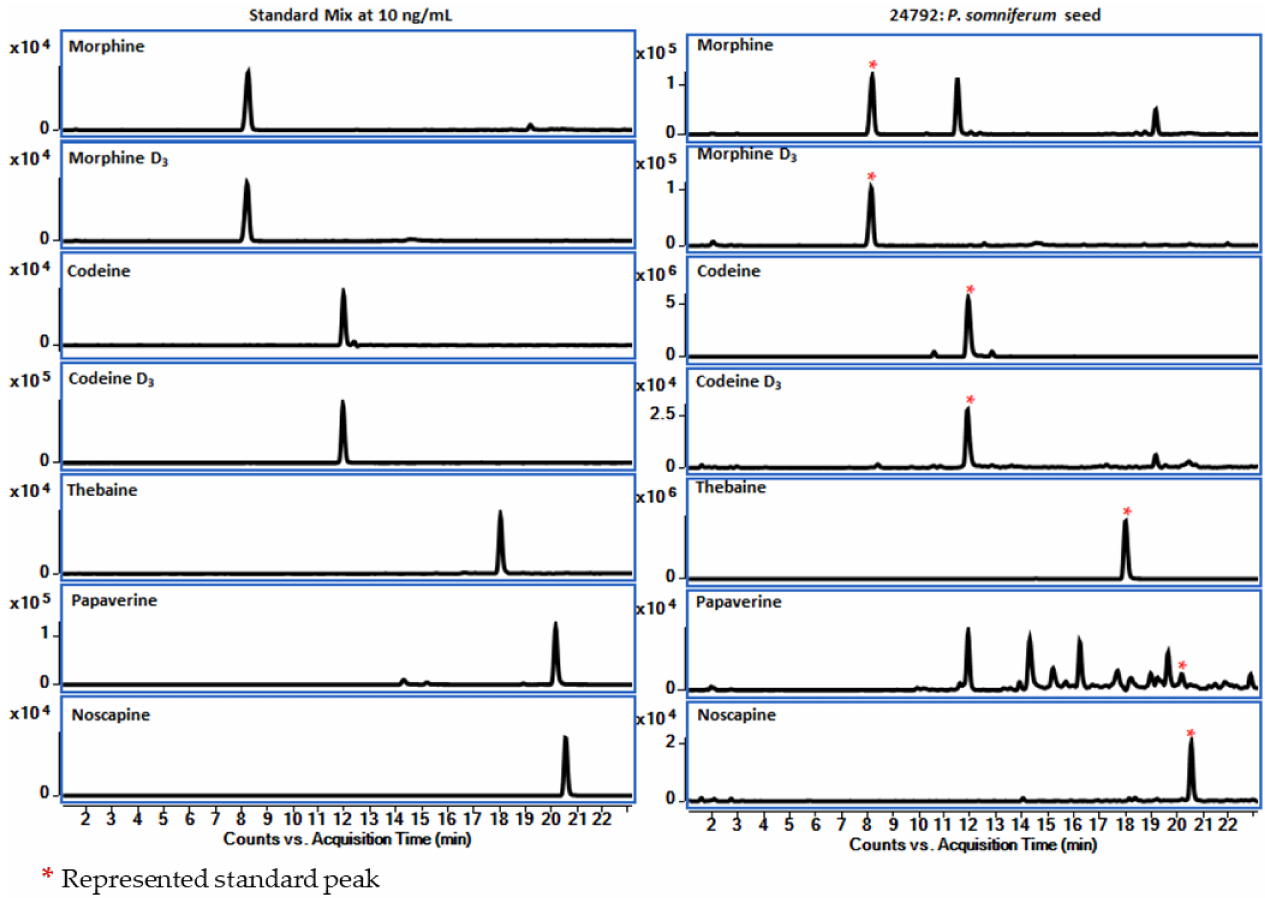
Figure 8. Extracted ion chromatograms of five OAs and internal standards (*) from the standard mixture and poppy seed sample